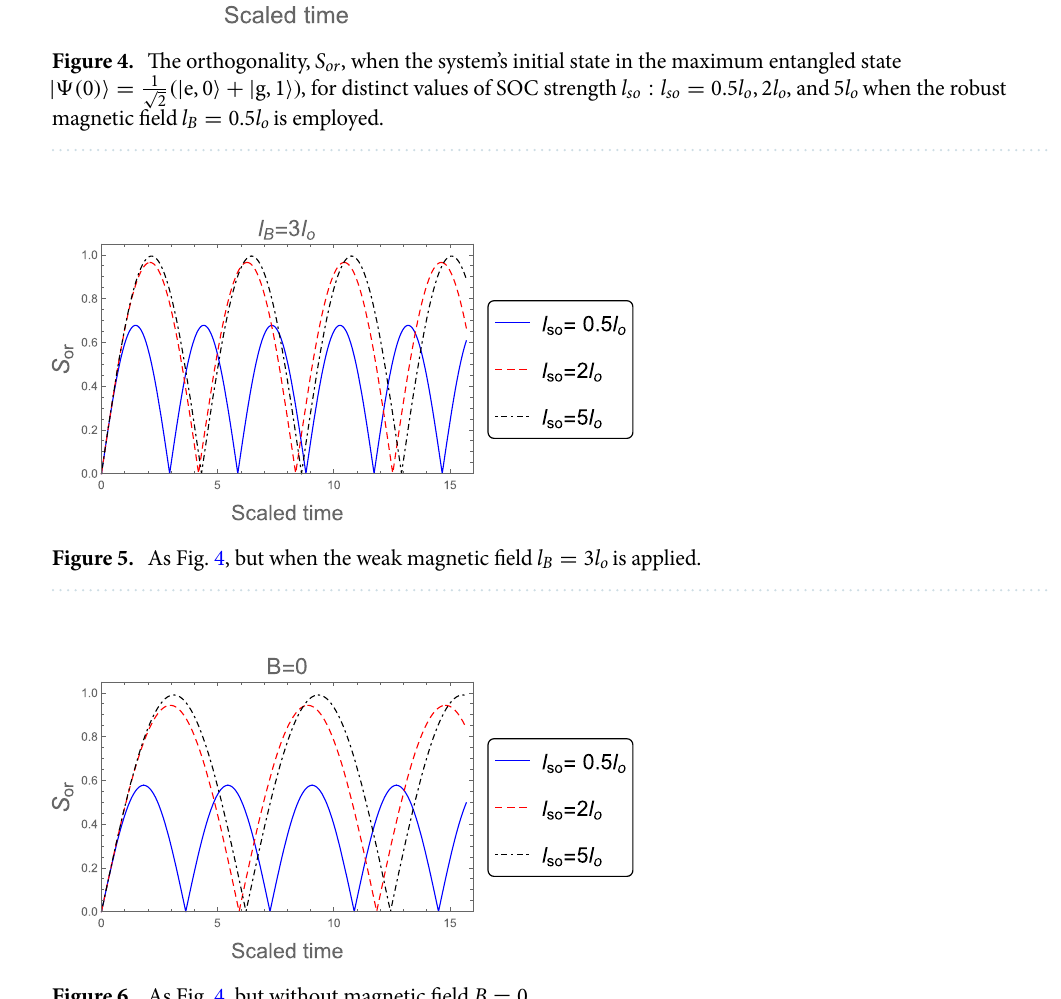
Figure 6. As Fig. 4, but without magnetic field B